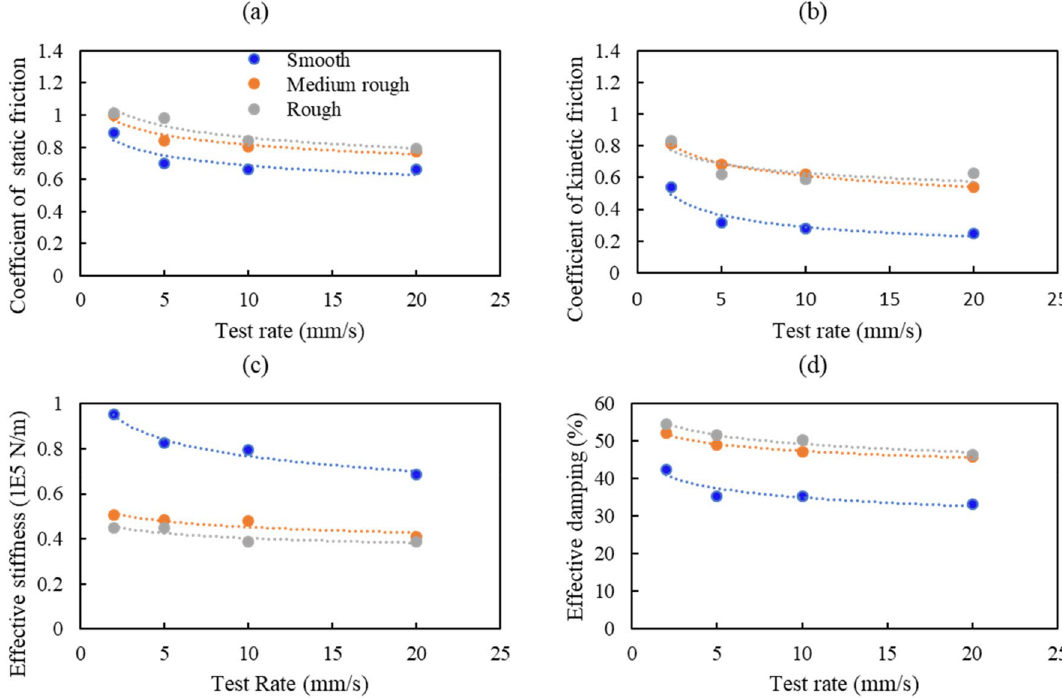
Figure 16. Variation of selected response quantities with the test rate at 0.0 MPa additional normal stress.